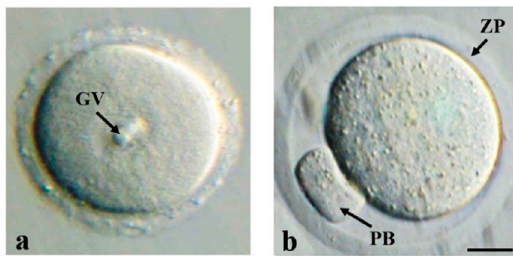
Figure 2. Fully grown mouse oocytes. ( a ) GV stage. To show the GV, surrounding cumulus cells have been mechanically removed. ( b ) MII stage. Expanded cumulus cells have been removed to